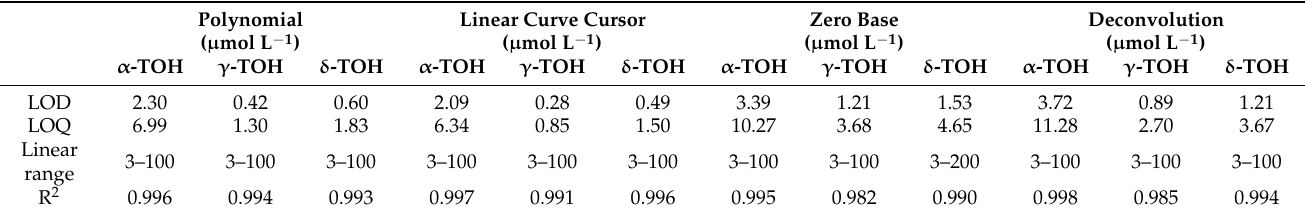
Table 2. All analytical parameters with four different methods for evaluation of signals.